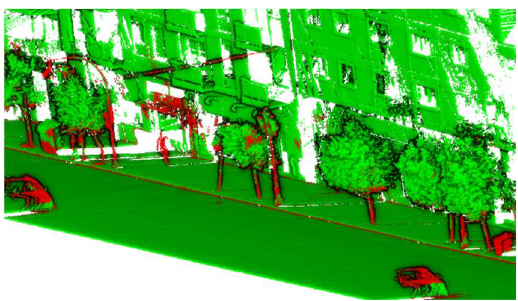
Figure 9: Point cloud coloured by correct semantic Figure 12: Point cloud coloured by correct semantic segmentation for 3 classes, 500 hidden layers and weighted. segmentation for 11 classes, 500 hidden layers and Correct segmented classified point in green and misclassified unweighted. Correct segmented classified point in green and in red. misclassified in red.